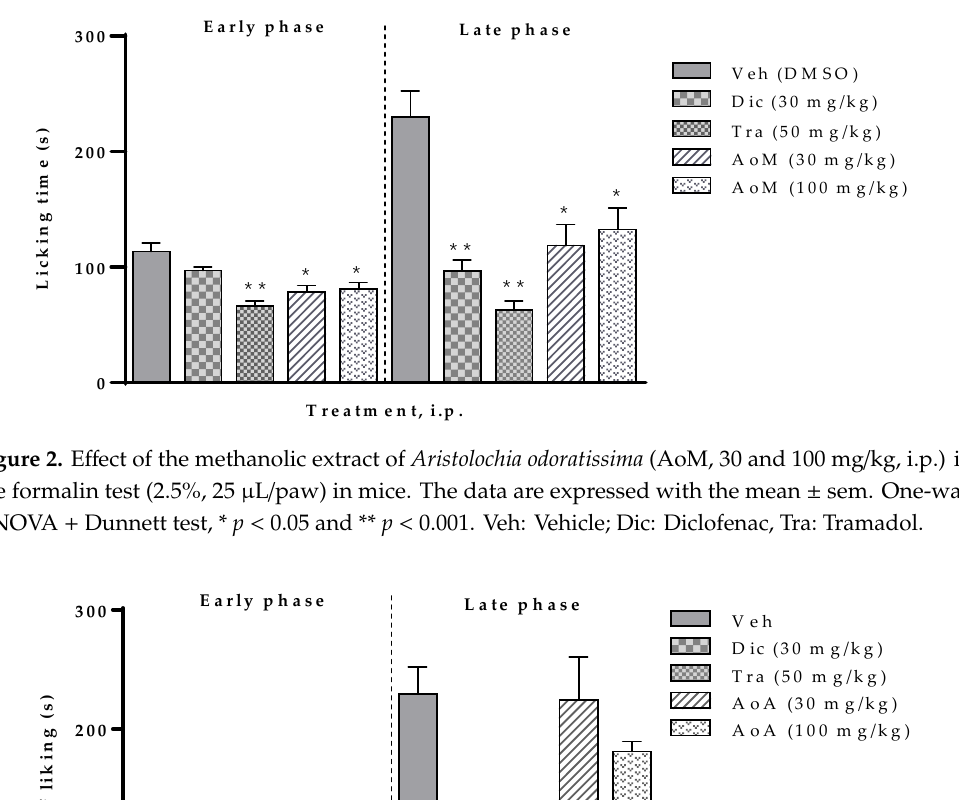
Figure 2. Effect of the methanolic extract of Aristolochia odoratissima (AoM, 30 and 100 mg/kg, i.p.) in the formalin test (2.5%, 25 µL/paw) in mice. The data are expressed with the mean ± sem. One-way ANOVA + Dunnett test, * p < 0.05 and ** p < 0.001. Veh: Vehicle; Dic: Diclofenac, Tra: Tramadol.